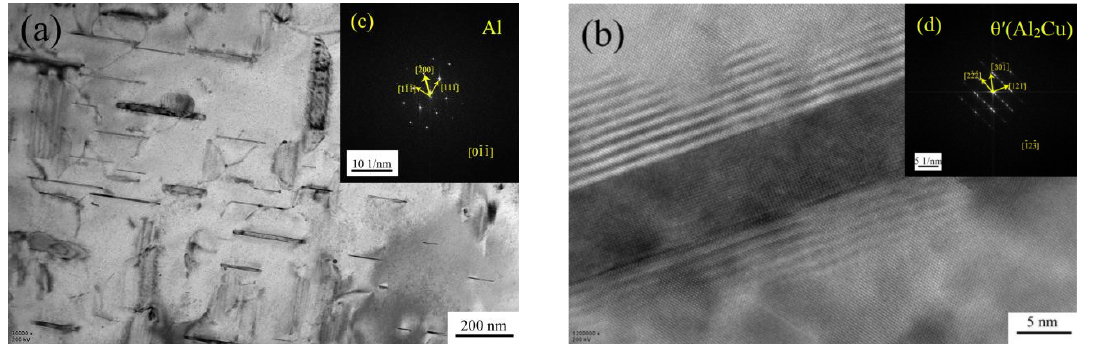
Figure 13. Bright-field image and HRTEM image of the unmodified ZL205A alloy after T5 treat- ment: ( a ) bright-field image, ( b ) θ’-phase HRTEM image, ( c ) diffraction pattern of the α phase, and ( d ) diffraction pattern of the θ’ phase.